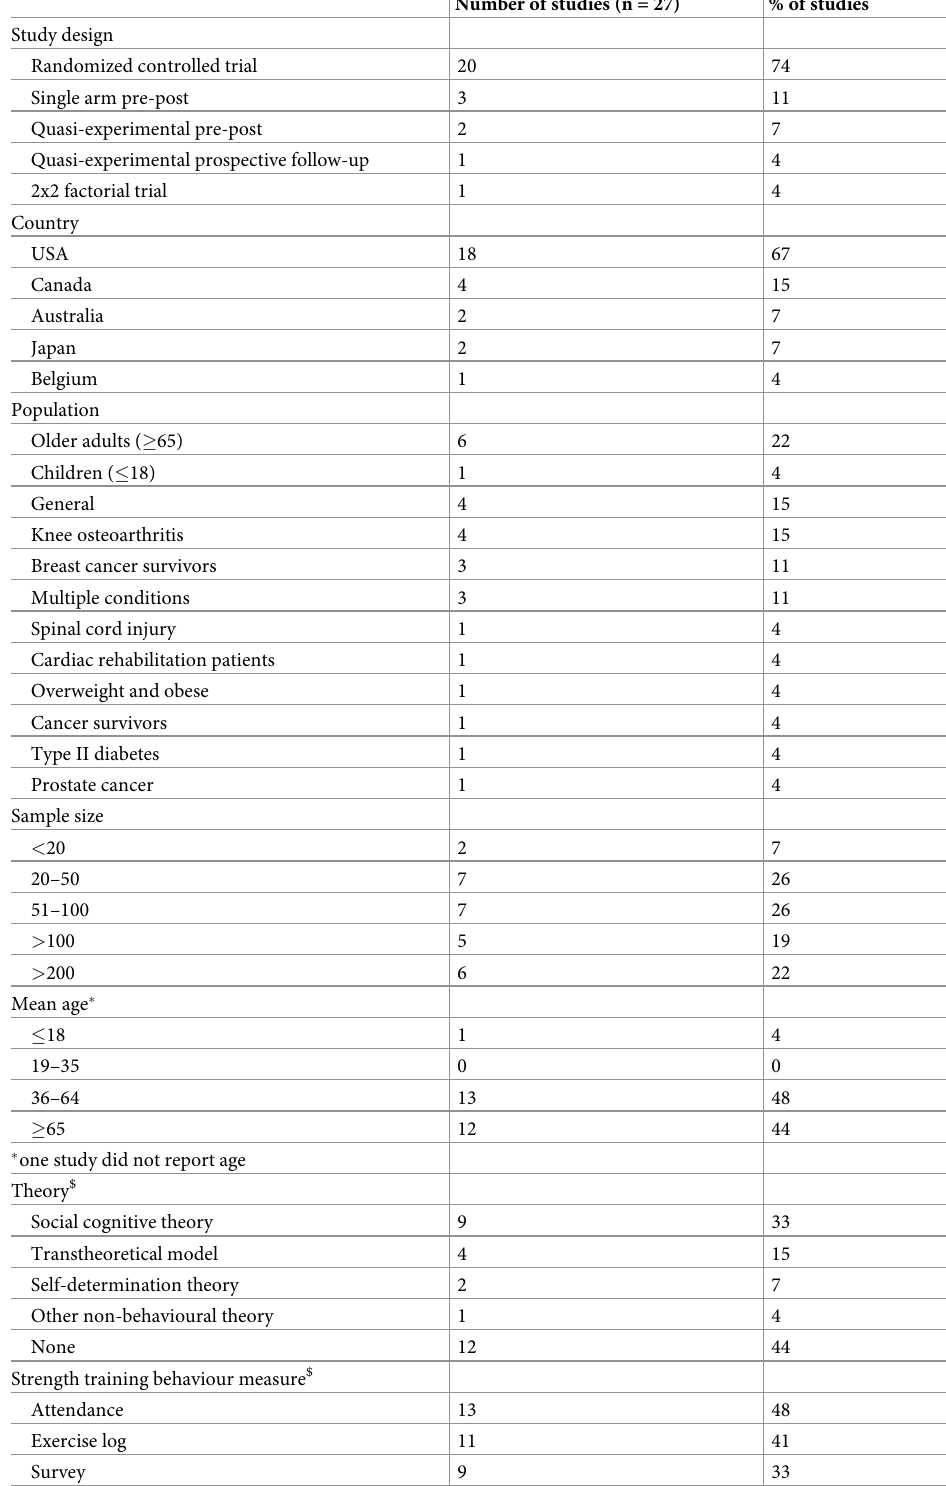
Table 1. Study characteristics and use of